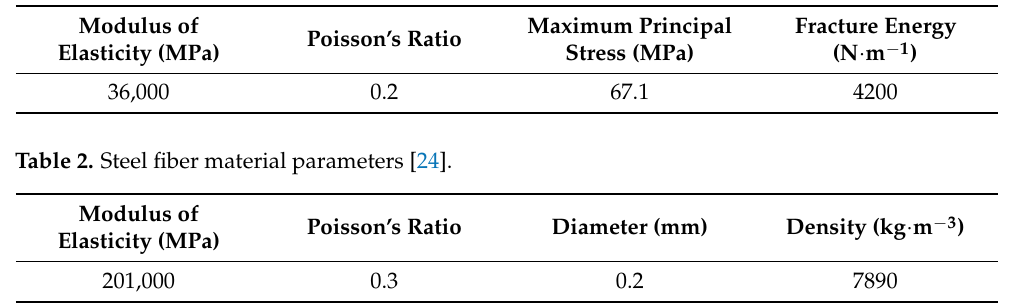
Table 1. Concrete material parameters [23].